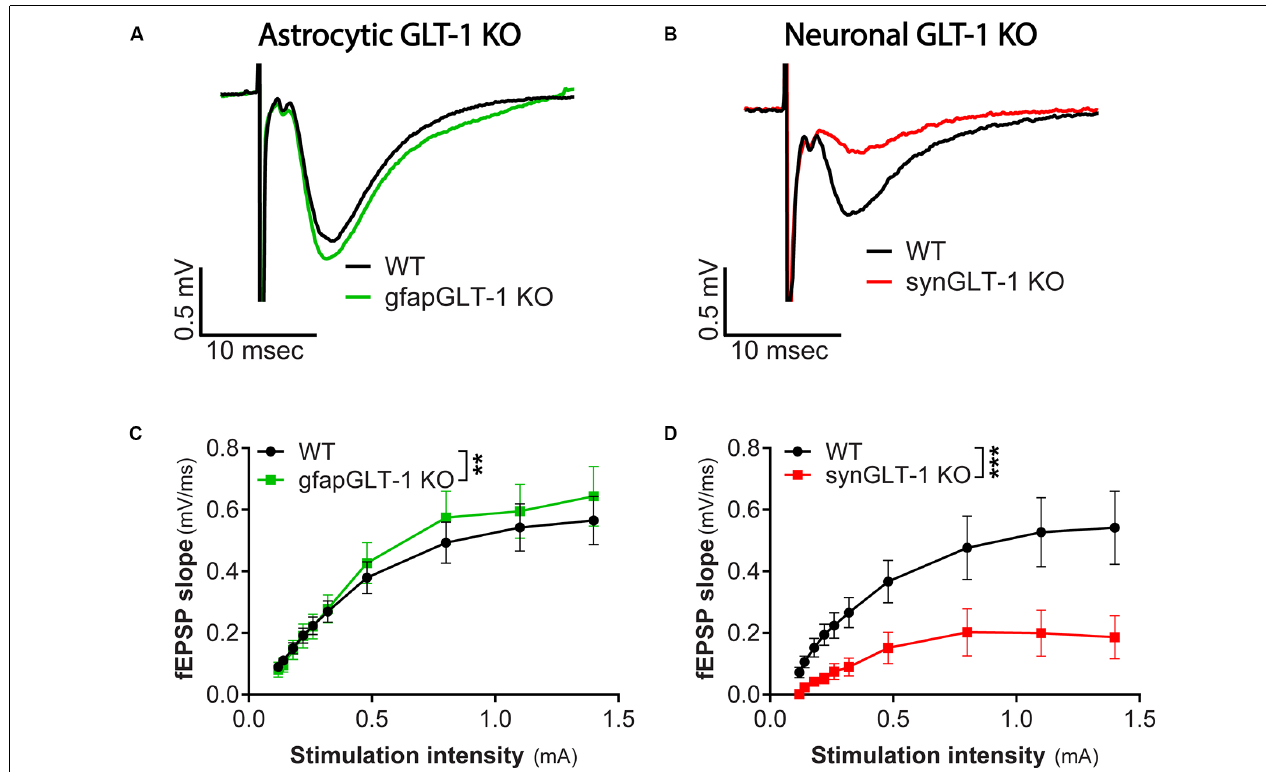
FIGURE 1 | Decreased field potentials in CA1 region of hippocampal slices from synGLT-1 KO but not gfapGLT-1 KO mice. Field excitatory post-synaptic potentials (fEPSPs) were recorded in the stratum radiatum in the CA1 region of hippocampal slices in response to a single electrical stimulus applied to the Schaeffer collateral/commissural fibers in 30–40 weeks old gfapGLT-1 KO (“Astrocytic GLT-1 KO”; A,C ) and 30–40 weeks old synGLT-1 KO (“Neuronal GLT-1 KO”; B,D ) mice and wild-type (WT) littermate controls. (A) Representative traces from WT (black trace) and gfapGLT-1 KO (green trace) littermates (0.3 mA stimulus). (B) Representative traces from WT (black trace) and synGLT-1 KO (red trace) littermates (0.3 mA stimulus). (C,D) Input-output relationship of fEPSP slope produced by stimuli between 0 and 1 mA in gfapGLT-1 and WT littermates (C) and in synGLT-1 KO and WT littermates (D) . ** = p < 0.01, *** = p < 0.001 in panels (C,D) indicate effect of genotype in a linear mixed